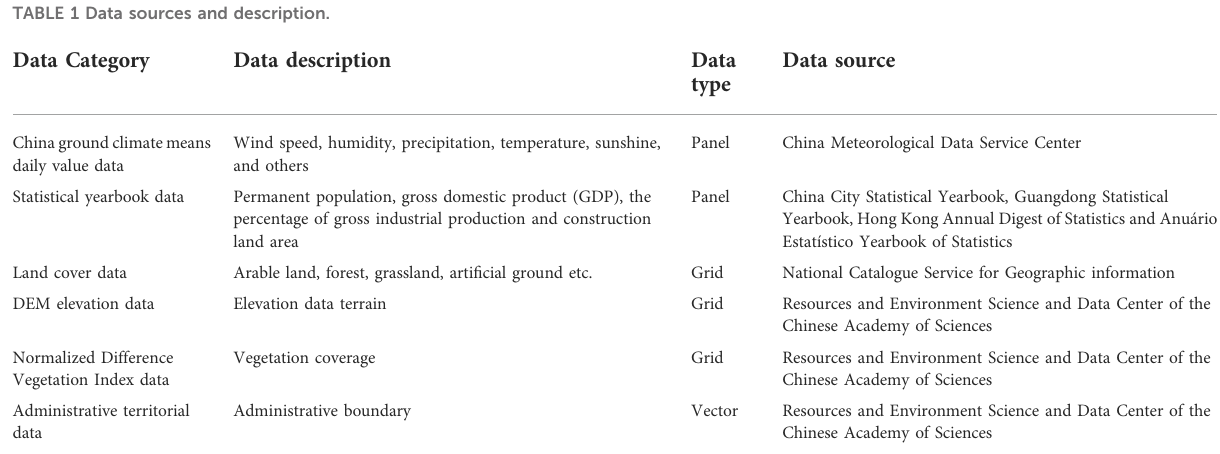
TABLE 1 Data sources and